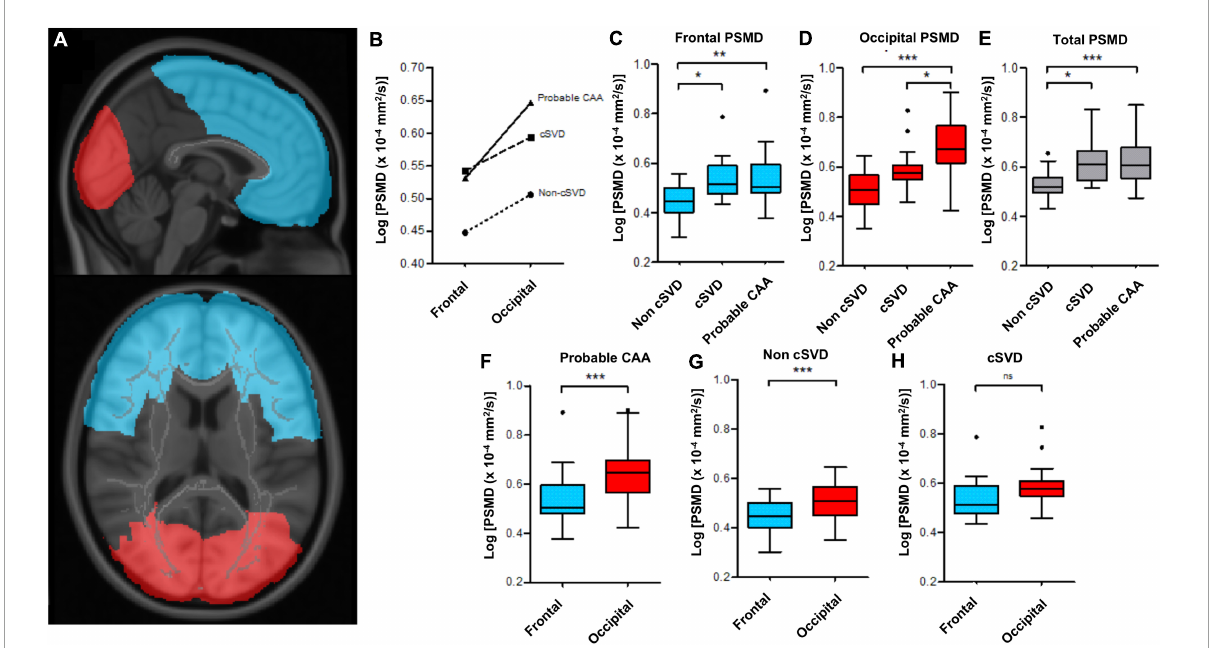
FIGURE1 Regional differences in PSMD values between probable-CAA, cSVD and non-cSVD groups. (A) Frontal (blue) and occipital (red) masks, used to compute lobe-specific PSMD values. (B) The line graph depicts mean log-PSMD values in the frontal and occipital lobes of probable-CAA (solid line), cSVD (dashed line), and non-cSVD (dotted line) subjects. (C–H) Box-plots of PSMD values. The boxes extend from the 25th to 75th percentiles, and the solid line within each box represents the median. The superior and inferior inner fences represent the 75th percentile plus 1.5 times the interquartile range and the 25th minus 1.5 times the interquartile range, respectively. Outliers are displayed by symbols. (C – E) Box plots contrasting frontal (C) , occipital (D) , and total (E) PSMD values between non-cSVD, cSVD, and probable-CAA groups. (F–H) Box-plots display frontal (blue) and occipital (red) PSMD within each study group. General linear models adjusted for age are indicated by the brackets, with p -values (* p < 0.05; ** p < 0.01; *** p <